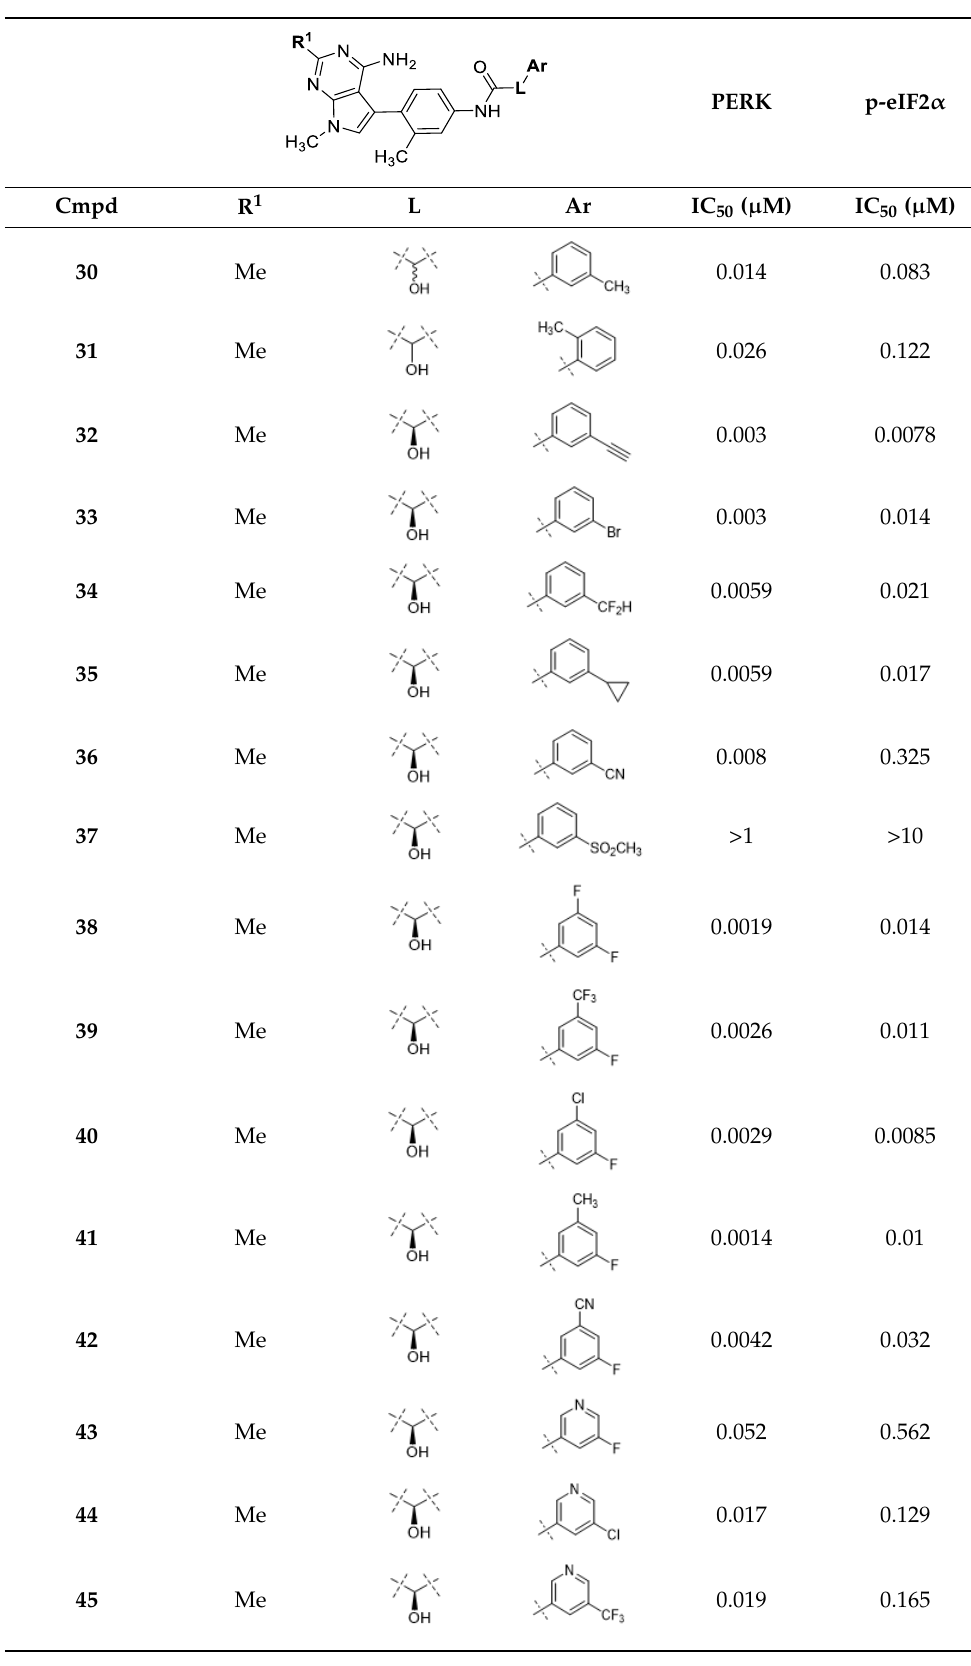
Table 2. In vitro data of PERK Table 2. Cont .